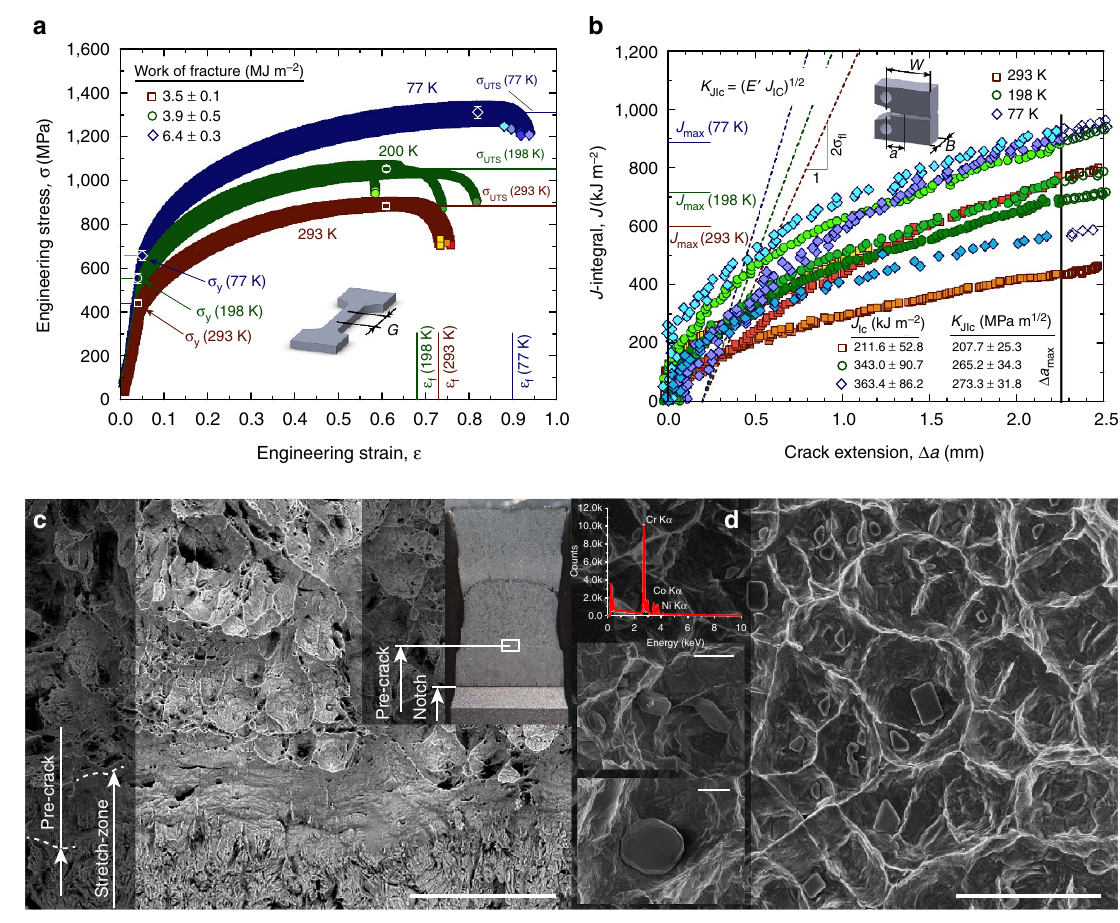
Figure 2 | Mechanical properties and failure characteristics of the CrCoNi medium-entropy alloy. ( a ) Tensile tests show a significant increase in yield strength, s y , ultimate tensile strength, s UTS and strain to failure, e f , with decreasing temperature from room temperature, 293K, to cryogenic temperatures, 198 and 77K. In the same temperature range, the work of fracture increases from 3.5MJm (cid:2) 2 to 6.4MJm (cid:2) 2 . ( b ) Fracture toughness tests on compact- tension, C(T), specimens show an increasing fracture resistance with crack extension and crack initiation, K JIc , values of 208, 265 and 273MPam 1/2 at 293, 198 and 77K, respectively. ( c ) Stereo microscopy and scanning electron microscopy images show a clear transition from the notch to the pre-crack and a pronounced stretch-zone between the pre-crack and the fully ductile fracture region of a sample that was tested at 198K. ( d ) The fracture surface shows ductile dimpled fracture and Cr-rich particles that act as void initiation sides. (Data points shown are mean ± s.d.; see Supplementary Table 1 for exact values.) The scale bars in c and d , and the insets of d are 75, 5 and 2 m m,